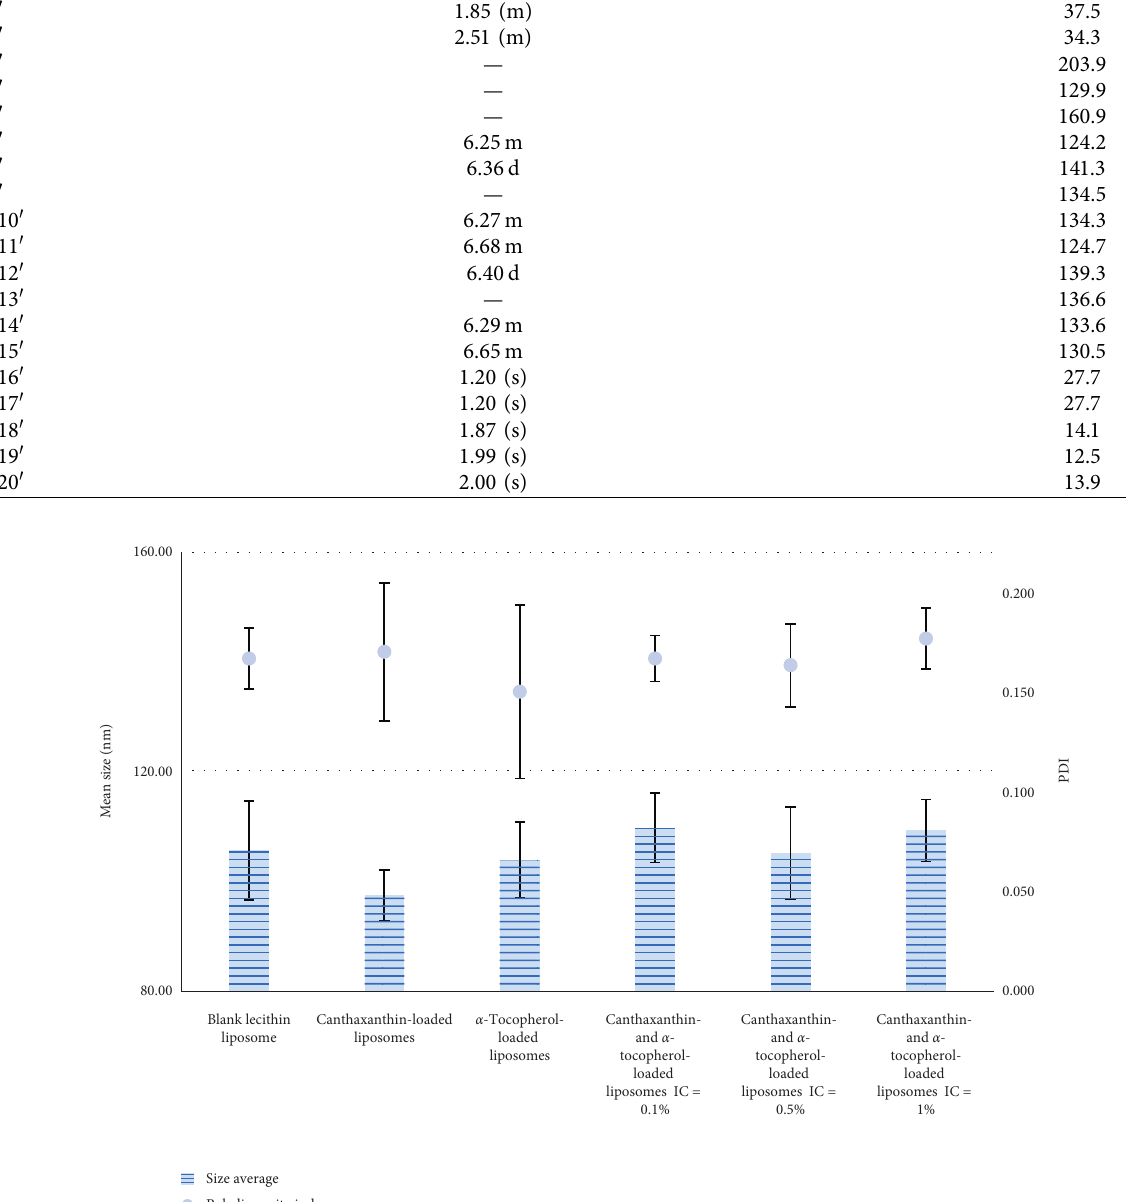
Figure 3: Mean size and PDI of blank lecithin liposome, canthaxanthin-loaded liposomes, α -tocopherol-loaded liposomes, canthaxanthin- and α -tocopherol-loaded liposomes with IC � 0.1%, canthaxanthin- and α -tocopherol-loaded liposomes with IC � 0.5%, and canthaxanthin- and α -tocopherol-loaded liposomes with IC �